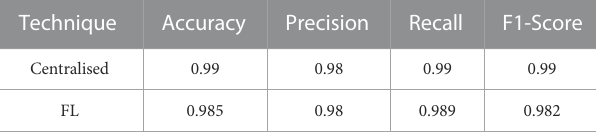
TABLE 2 Comparative results for centralised learning and proposed VFWN for beam blockage